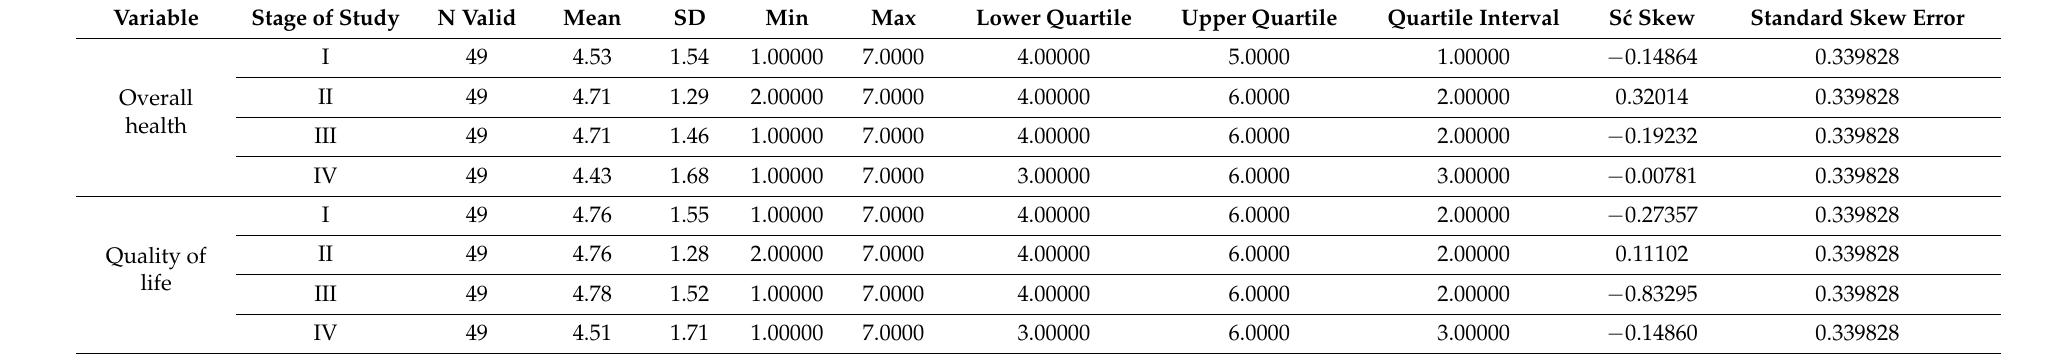
Table 3. Quality of life (QoL) and overall health assessment by the respondents.